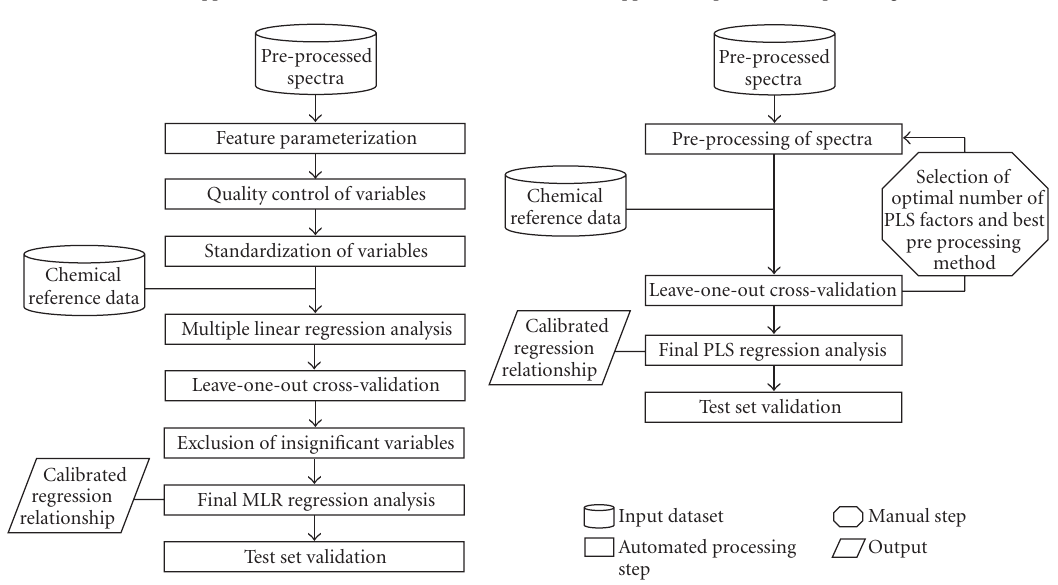
Figure 6: Work flow for feature-based MLR and PLS regression